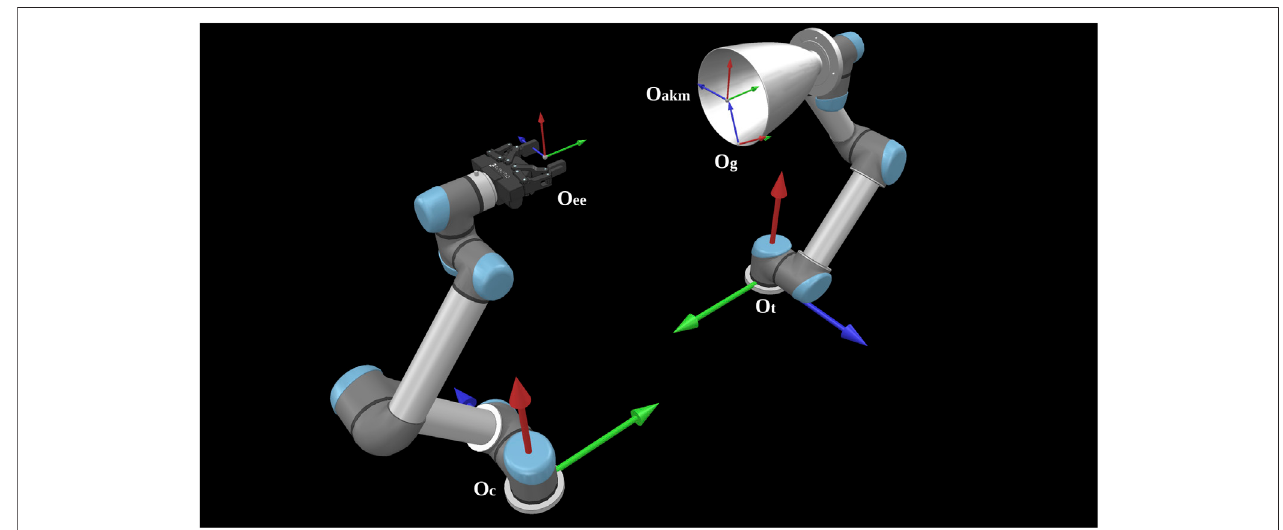
FIGURE 14 | The coordinate frames used for slippage calculation for our real experiment.